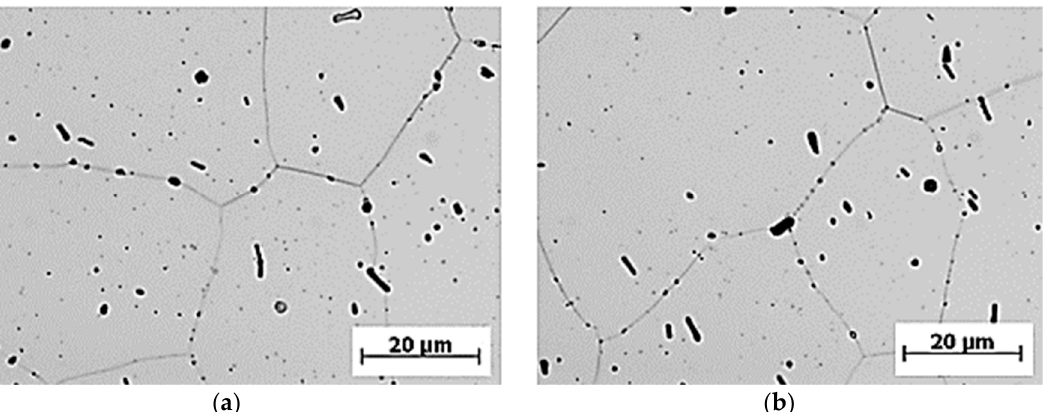
Figure 3. The microstructure of the selected alloy EN AW 6063.T66 in ( a ) the longitudinal direction, and ( b ) the transversal direction, etched by 0.5% HF.